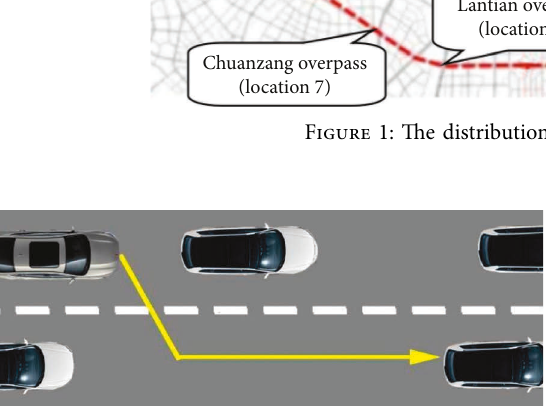
Figure 2: Exhibition map of vehicle behavior of changing lane (from the